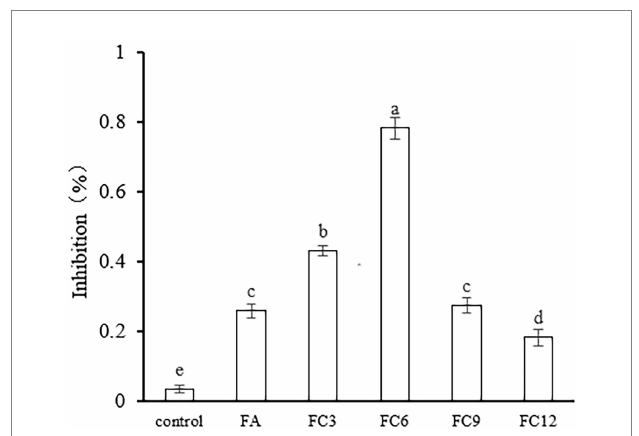
FIGURE 4 Effect on Pseudomonas aeruginosa biofilm formation.